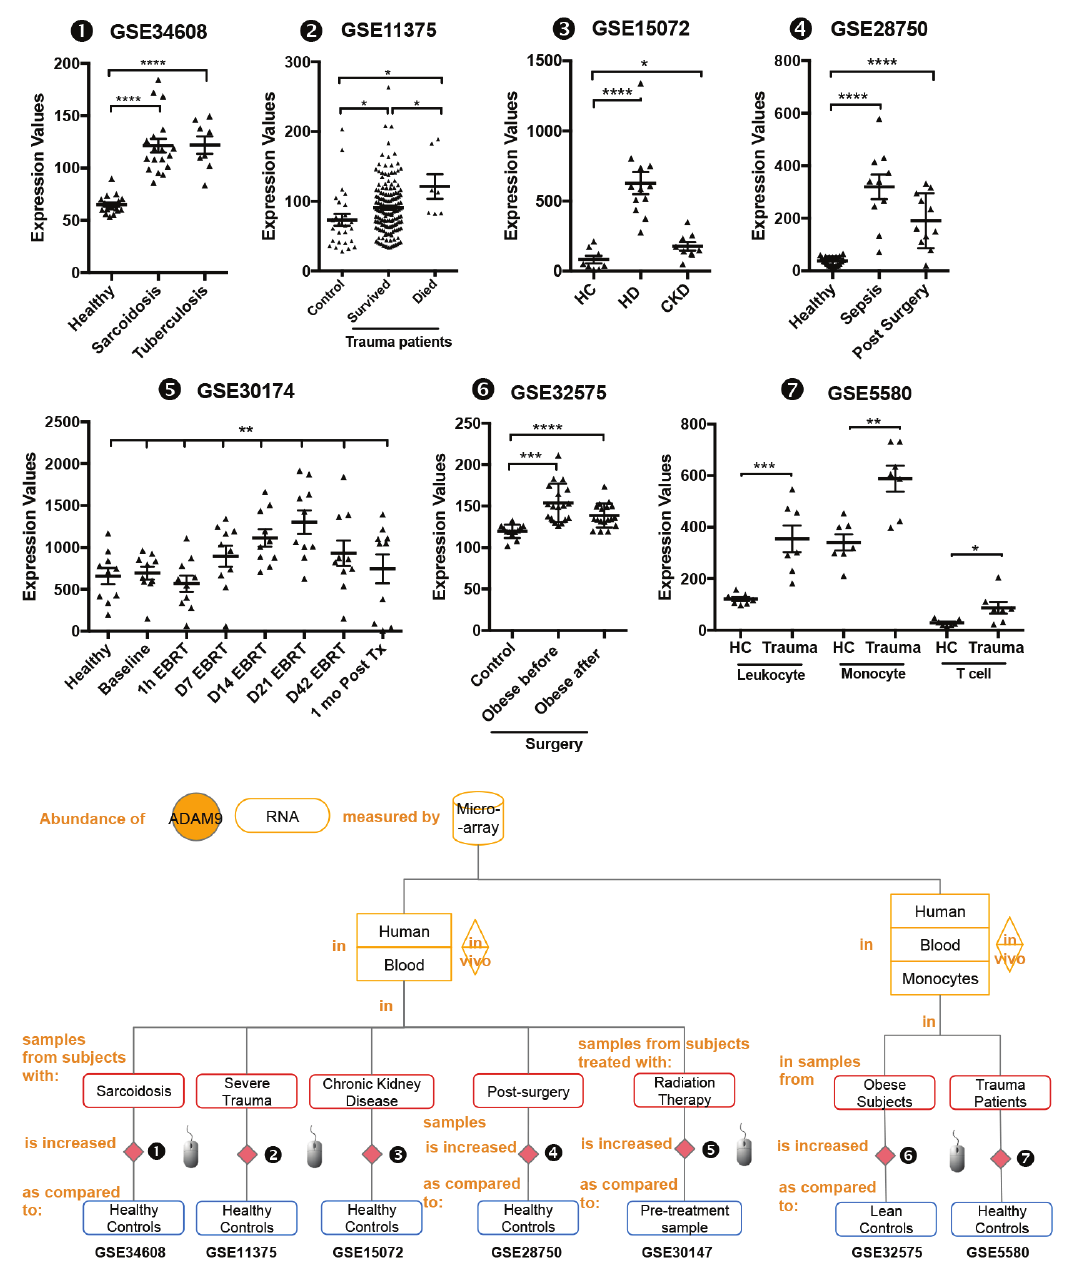
Figure 5. The abundance of ADAM9 increases following tissue injury and sterile inflammation. mRNA expression levels for ADAM9 was measured by microarrays in whole blood obtained from patients with active tuberculosis and sarcoidosis (GSE34608), from patients following severe blunt trauma within 12 hours of traumatic injury who survive and non-survive (GSE11375), from blood of patients with stage II-III Chronic kidney disease (CKD), patients undergoing hemodialysis treatment (HD) and healthy controls (GSE15072), from septicemic patients (GSE28750), from 10 men with non-metastatic prostate cancer; baseline (before External Beam Radiation Therapy - EBRT); days 1, 7, 14, 21, 42 of EBRT; and 30 days post-EBRT (GSE30147) and monocyte from blood of 18 morbidly obese subjects before and three months after bariatric surgery (GSE32575) and from seven subjects with defined multi organ dysfunction syndrome that developed after experiencing severe traumatic injury (GSE5580). The graphical legend represents visually the information associated with the public datasets used for the meta-interpretation of ADAM9 transcriptional profiles. (https://docs.google.com/presentation/d/12ytv11_LmMOAsocziIAe8MwwKOrGgHSO60hpdK2hHsQ/edit#slide=id. g496fd210c_046). The flow chart indicates how data were generated. Diamonds indicate availability of supporting data and in the interactive version are hyperlinked to context-rich interactive plots. Links to these plots are also provided